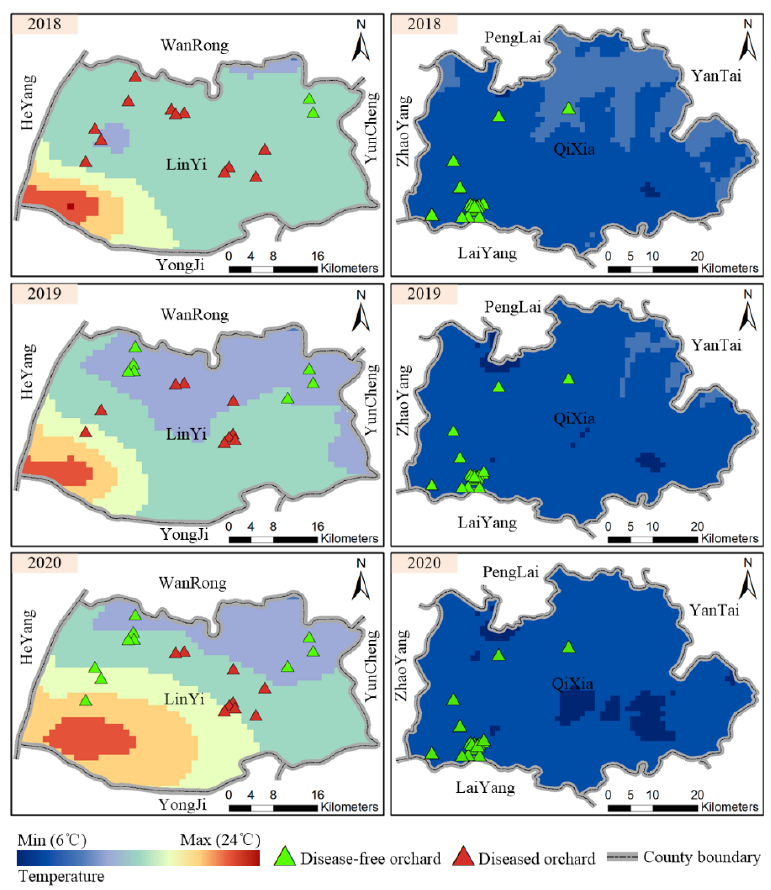
Figure 5. Spatial distribution of the average temperature from March to June in the study area from 2018 to 2020. Table 2. The t -test sensitivity analysis of ten-day average temperature and ten-day average relative humidity between healthy and diseased samples from March to June.